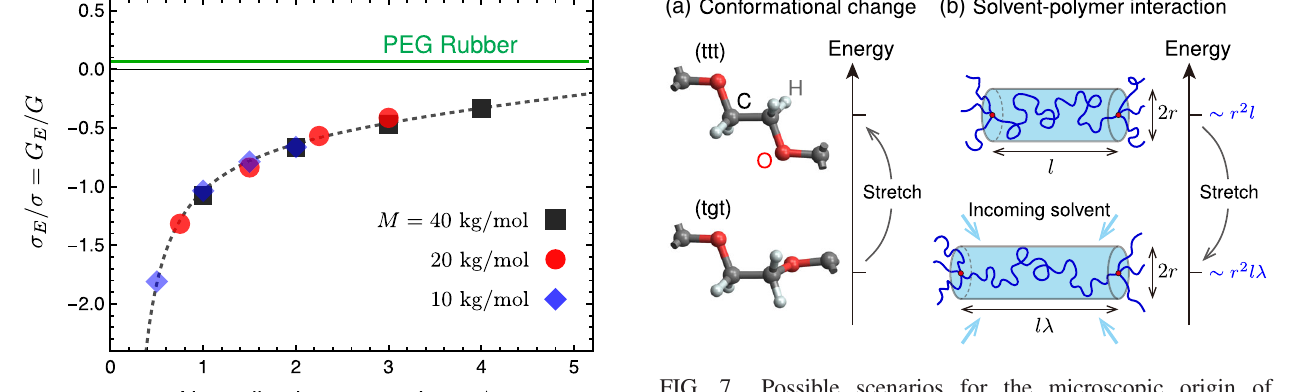
FIG. 7. Possible scenarios for the microscopic origin of negative energy elasticity. (a) Energy change accompanying the conformational change with deformation of a PEG chain, which has been considered to be the origin of “ positive ” energy elasticity for PEG rubber [the green line in (a)] [8]. When the PEG chain is stretched, the trans-gauche-trans (tgt) conformation around successive O ─ C ─ C ─ O bonds is transformed to the trans- trans-trans (ttt) conformation. Because the conformational energy of trans around the C ─ C bond is higher than that of gauche originating from the dispersion interaction between the adjoining oxygen atoms [8], the energy elasticity is positive. (b) Energy change accompanying the attractive solvent-polymer interaction with deformation of a polymer (PEG) chain between cross-links, causing “ negative ” energy elasticity in the polymer gel. In the dilute regime ( c=c (cid:3) < 1 ), the “ territory ” of a chain (blue curves) between cross-links (red points) can be roughly described as cylindrical in shape (light blue region) with radius r and height l . When the chain is mechanically stretched at a stretch ratio λ , the number of solvent molecules interacting with the chain increases, decreasing the total energy of the